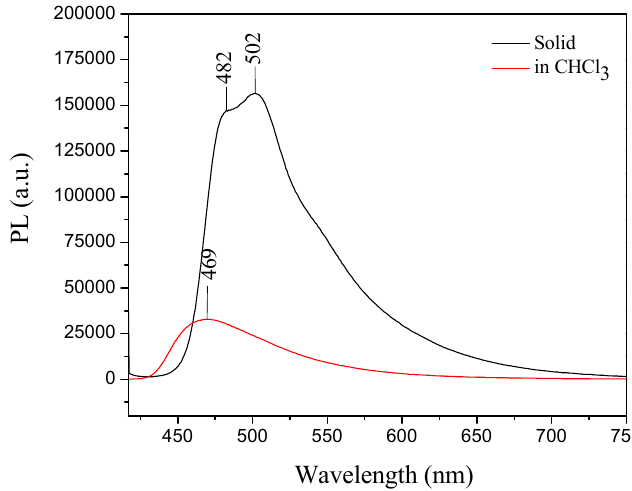
Figure 11. Emission of compound III in solid form ( − ) and in solution ( − ) indicating that III exhibited the AIE property. Excitation wavelength for both conditions was 405 nm.